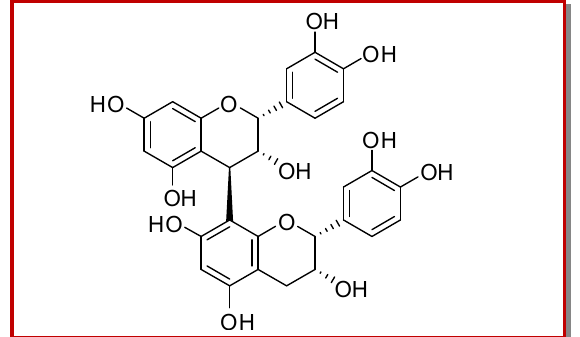
Figure 1: The chemical structure of procyanidin B2